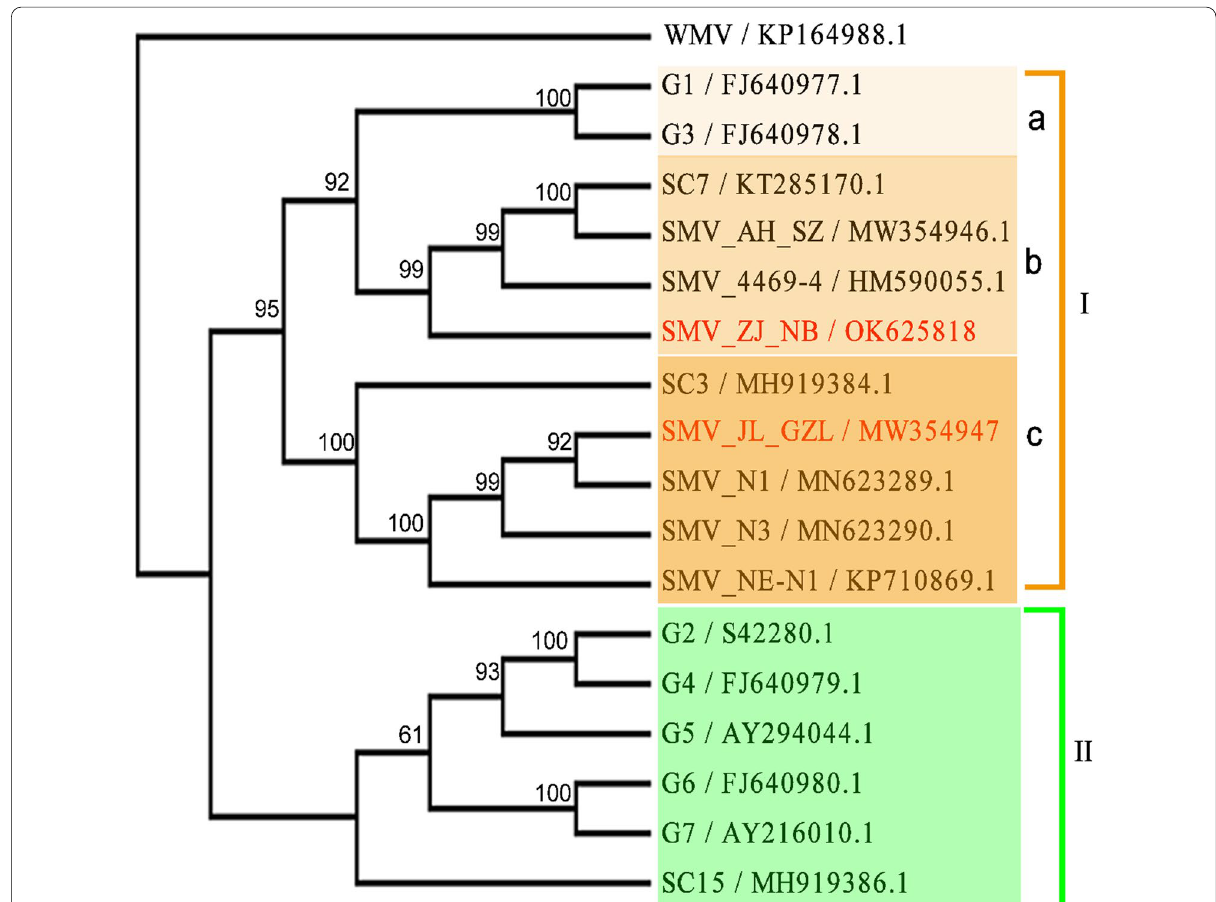
Fig. 3 Phylogenetic relationships among SMV isolates from different countries. The Maximum Likelihood phylogenic tree was constructed using MEGAX. The complete genome sequences of SMV isolates were obtained from NCBI (https:// www. ncbi. nlm. nih. gov/). The colored bars (orange and green) indicate the different clades observed in the phylogenies. The letters a, b and c indicate different subgroups in Clade